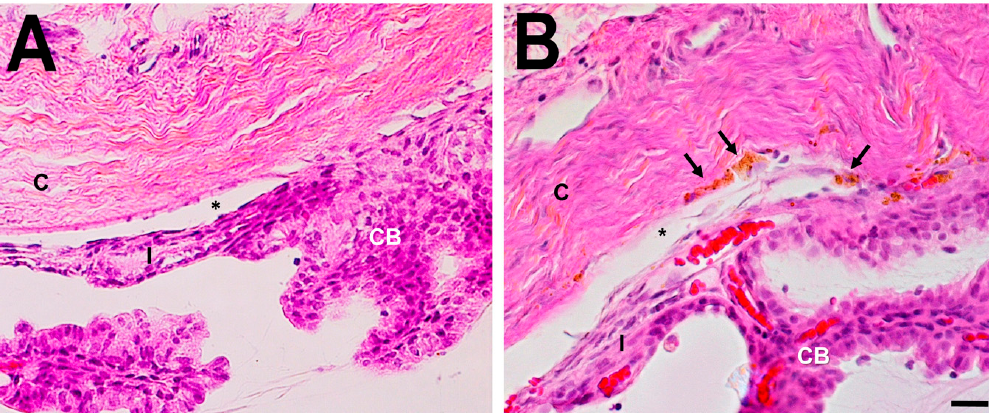
Figure 5. Histological examination of the anterior chamber angle two weeks after polidocanol injection. ( A ) Light microscopy of hematoxylin-eosin staining sections of the iridocorneal angle from an uninjected left control eye illustrating normal histology of trabecular meshwork area. ( B ) Angle from an experimental eye shows the presence of macrophages (arrows) on the trabecular meshwork area. Anterior chamber (*), cornea (C), ciliary body (CB) and iris root (I). Scale bar 20 µm. Retinal microstructure was analyzed by means of the OCT. At both week 2 and week 12, we did not observe any significant reduction in RNFL + GCL + IPL thickness (73.13 ± 3.46 µm) in the hypertensive eyes compared to the control eyes (74.52 ± 0.62 µm) (repeated measures ANOVA, n = 17, p > 0.05). Moreover, whole retina (194.98 ± 10.93 µm), ONL (49.49 ± 4.08 µm) and INL thicknesses (17.23 ± 1.44 µm) in the hypertensive eyes were not significantly different from the fellow control eyes’ whole retina (191.40 ± 10.93 µm), ONL (51.72 ± 5.07 µm) and INL thickness values (18.21 ± 0.87 µm) (repeated measures ANOVA, n = 17, p > 0.05).